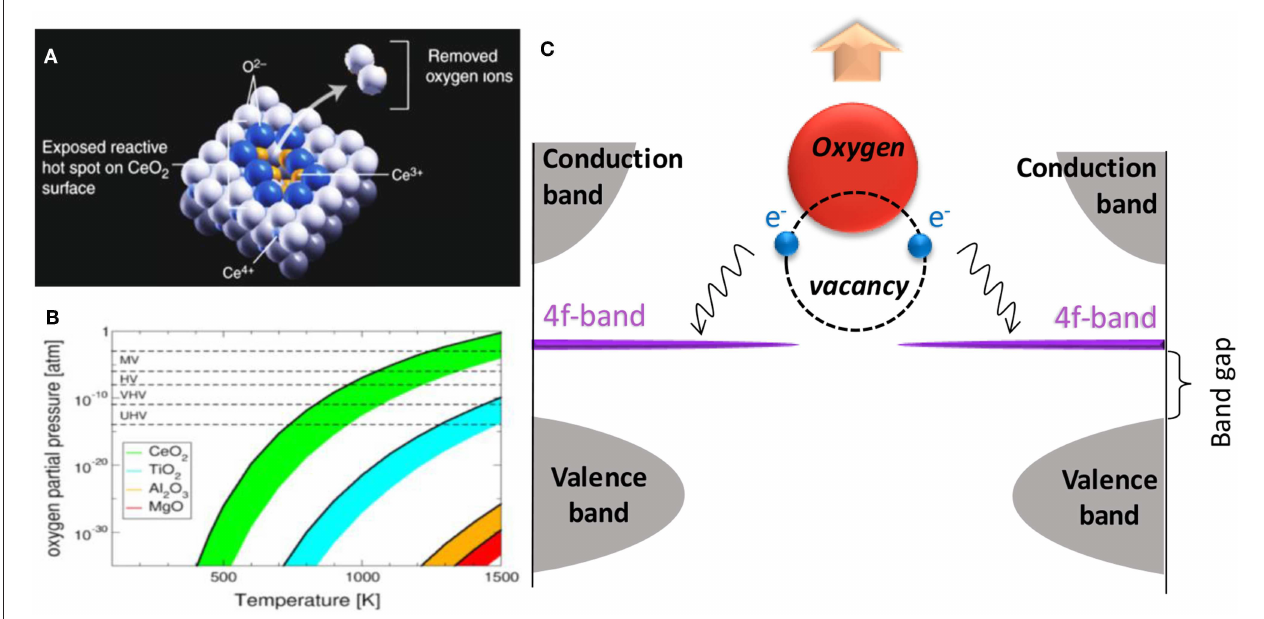
FIGURE 1 | (A) Illustration of vacancy formation on the surface of ceria; (B) Phase diagram of the transition curves of the crystalline structure in the presence of O 2 obtained by DFT (MV, medium vacuum; HV, high vacuum; VHV, very high vacuum; and UHV, ultra-high vacuum) and (C) Schematic of vacancy formation and its impact on the electronic levels of a reducible oxide (adapted from Esch et al., 2005; Sun et al., 2012; Paier et al., 2013).